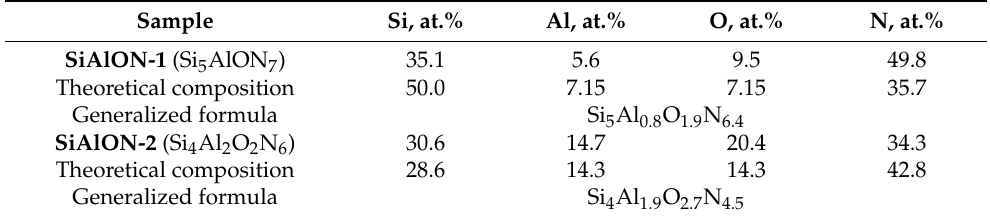
Figure 1. XRD-pattern of the samples SiAlON-1 ( a , b ) and SiAlON-2 ( c , d ). Table 1. Average content of elements in the samples SiAlON-1 and SiAlON-2 according to energy dispersive X-ray spectroscopy.